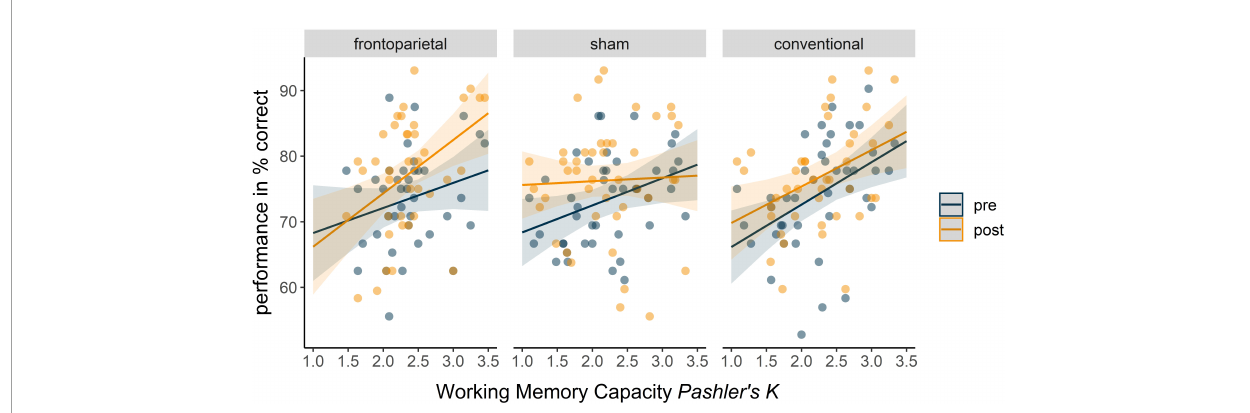
FIGURE4 Predicted overall performance in distractor condition (WM+) of the WM–/WM+ change-detection task in the three stimulation groups in dependence of WM capacity. Fixed factors of the full model included time, stimulation, WM capacity, and their interaction. Blue trajectories depict performance in the pre assessment of WM+, orange trajectories depict performance in the post assessment of WM+ across the WM capacity continuum. Dots represent participants’ performance in the pre (blue) and post (orange)